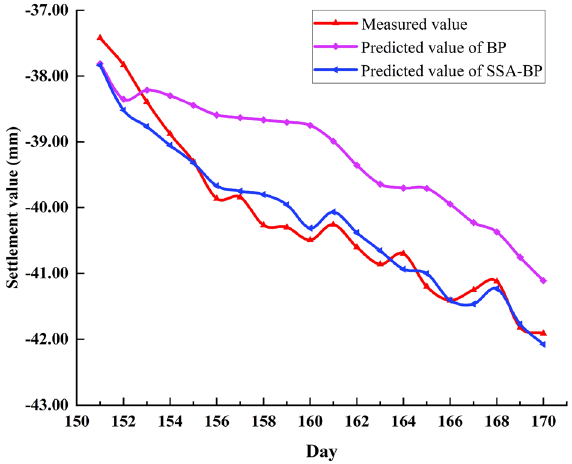
Figure 10. BP, SSA-BP predicted value and measured value at P2 point.